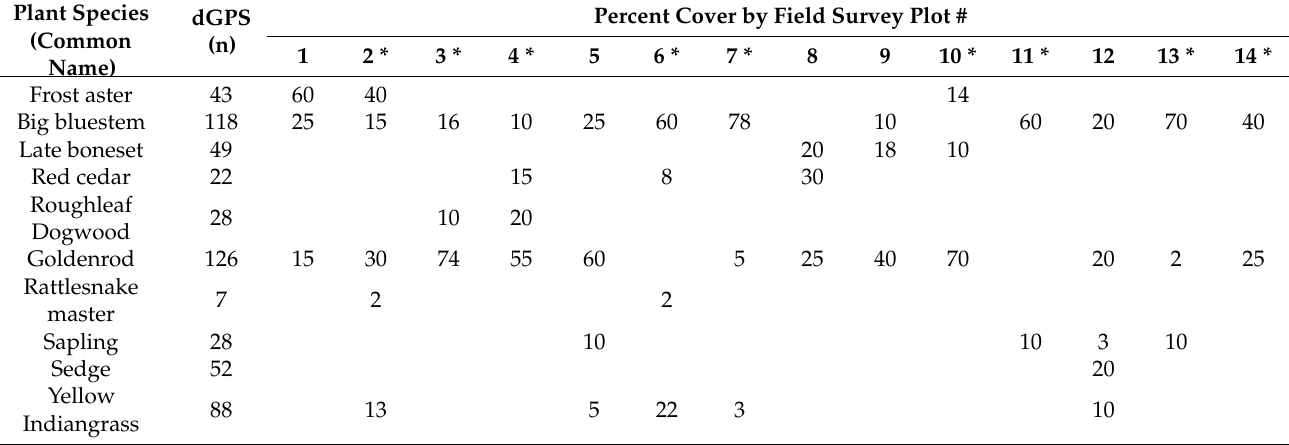
Figure 1. Tallgrass prairie study site in Champaign County, Illinois. Species cover and abundance plots (black, field survey plots) with randomized ground-truth data points. Plot numbers associate with Table 2. Table 2. Randomized dGPS points used to train and test classification models for each plant species. Corresponding percent cover values for each plant species are included for each of the fourteen 5 × 5 m 2 survey plots (Figure 1). Plot numbers with asterisks indicate the percent cover data used for validation (see Section 3.4). Not all plots add up to 100% cover. Note: sedges and deciduous saplings were not identified to species.